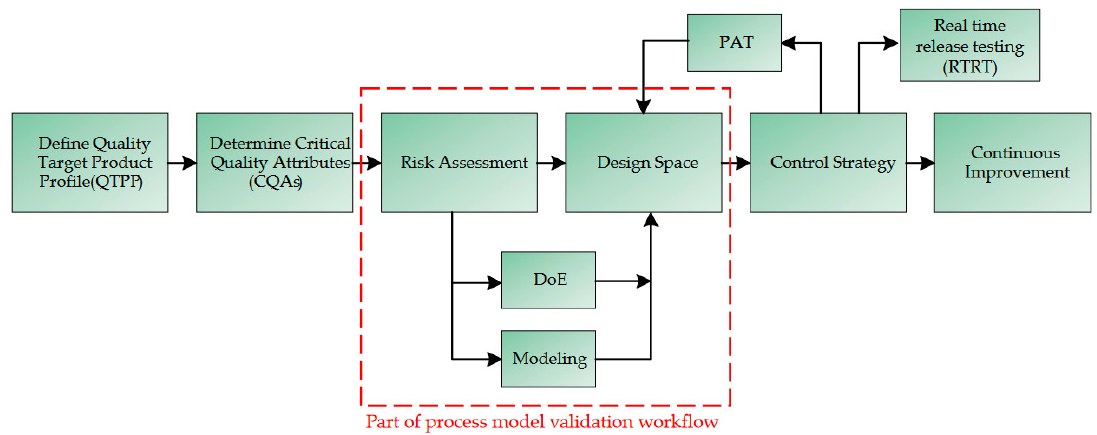
Figure 1. Presentation of the risk analysis and regulation within the framework of the QbD